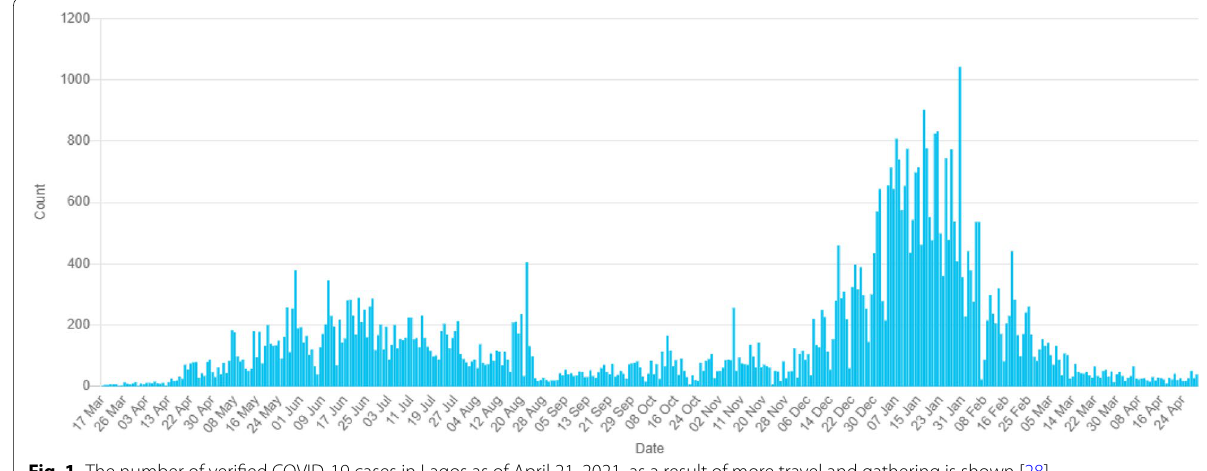
Fig. 1 The number of verified COVID‑19 cases in Lagos as of April 21, 2021, as a result of more travel and gathering is shown [28]